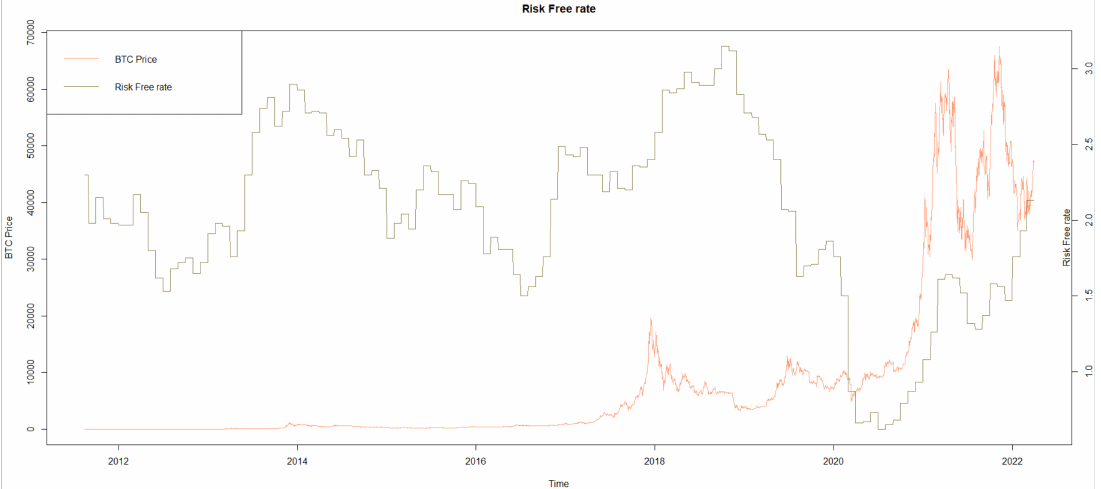
Figure 7. Bitcoin price and risk-free rate.